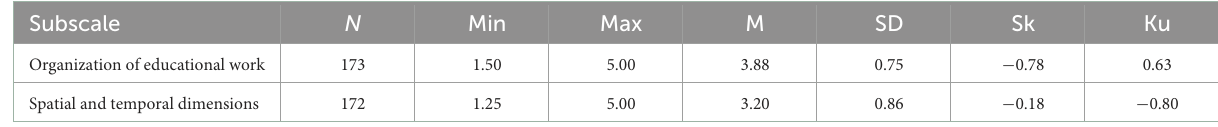
TABLE 2 Descriptive data for the subscales of the Scale of the State of School Culture